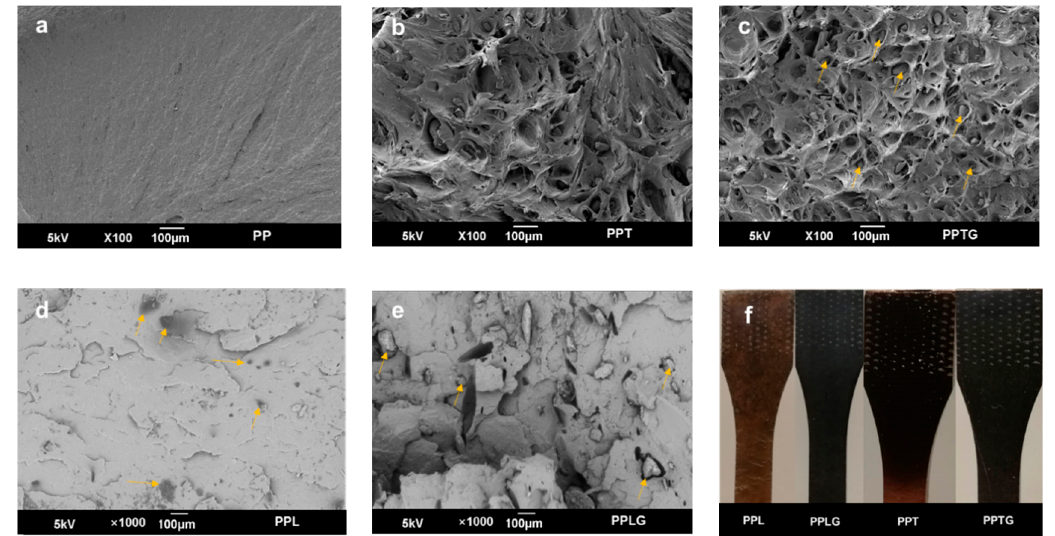
Figure 3. SEM images of fractured surfaces of pure PP ( a ), PP / polyphenol blends ( b , d ), and PP / crosslinked polyphenol blends ( c , e ) tested by tensile measurements; images of tested dog-bond specimens ( f ).